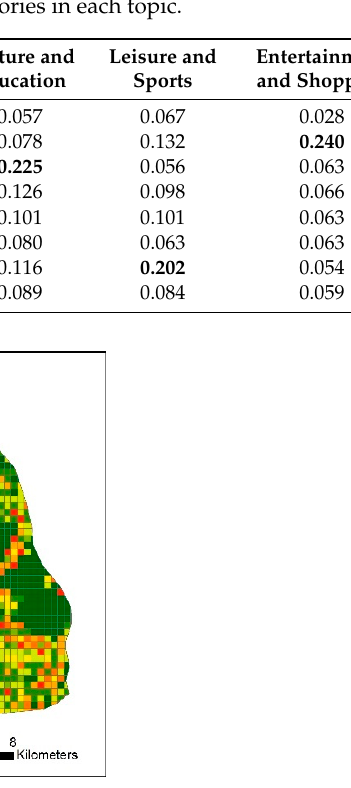
Figure 10. Topic distribution based on the H-LDA model.